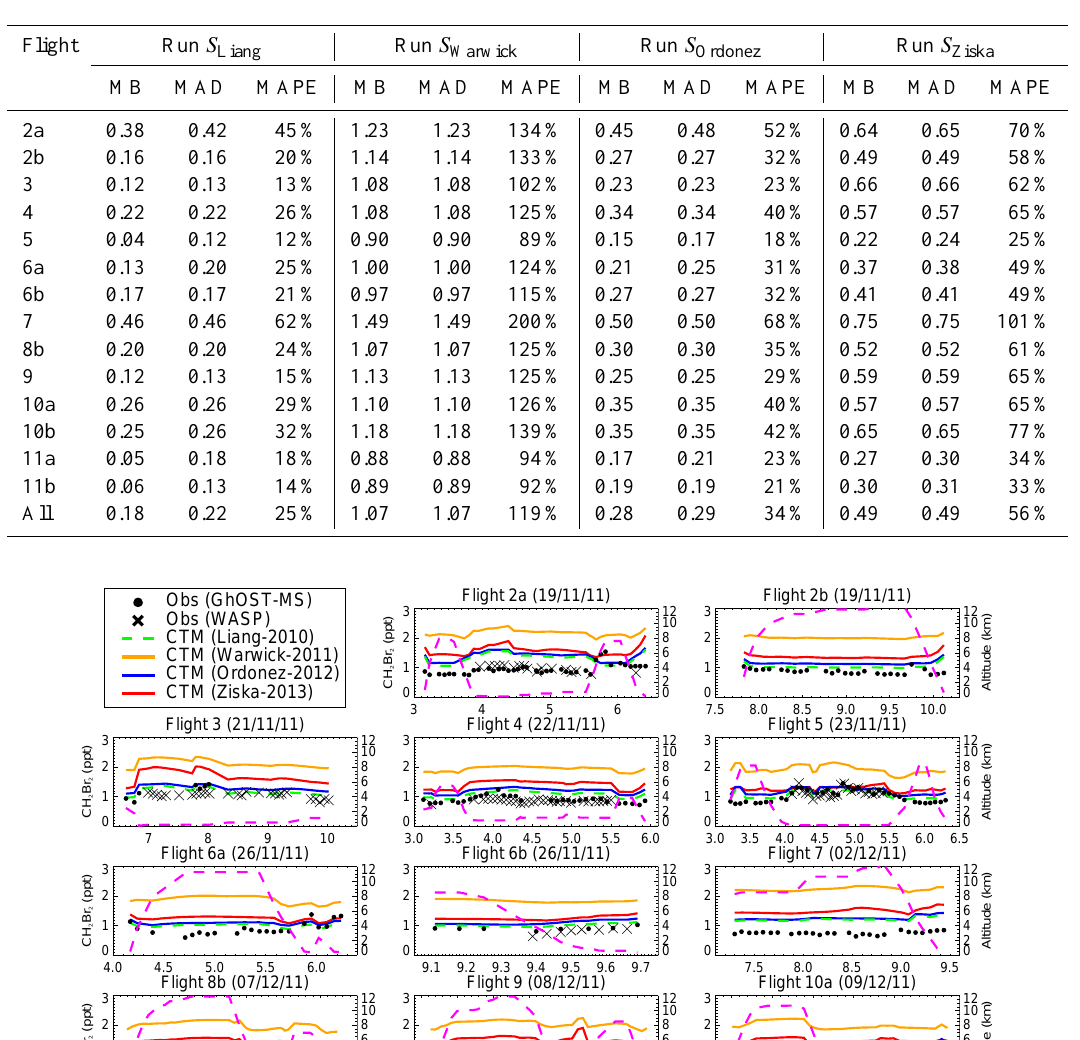
Table 8. As Table 7 but for CH 2 Br 2 .